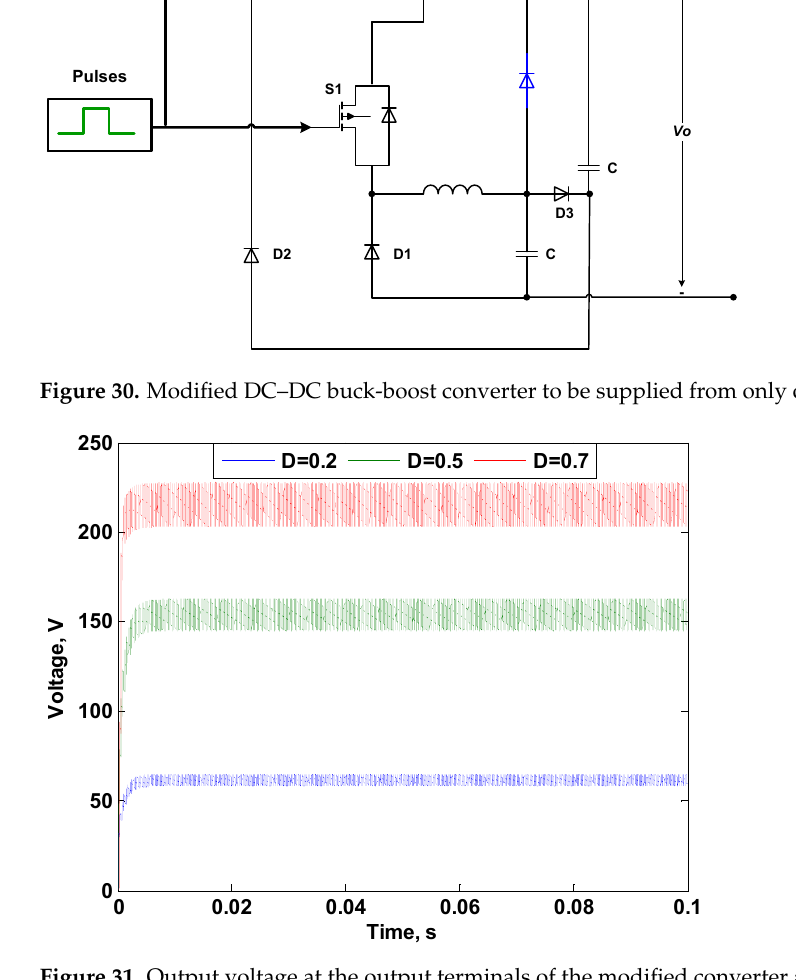
Figure 31. Output voltage at the output terminals of the modified converter at different duty ratios.